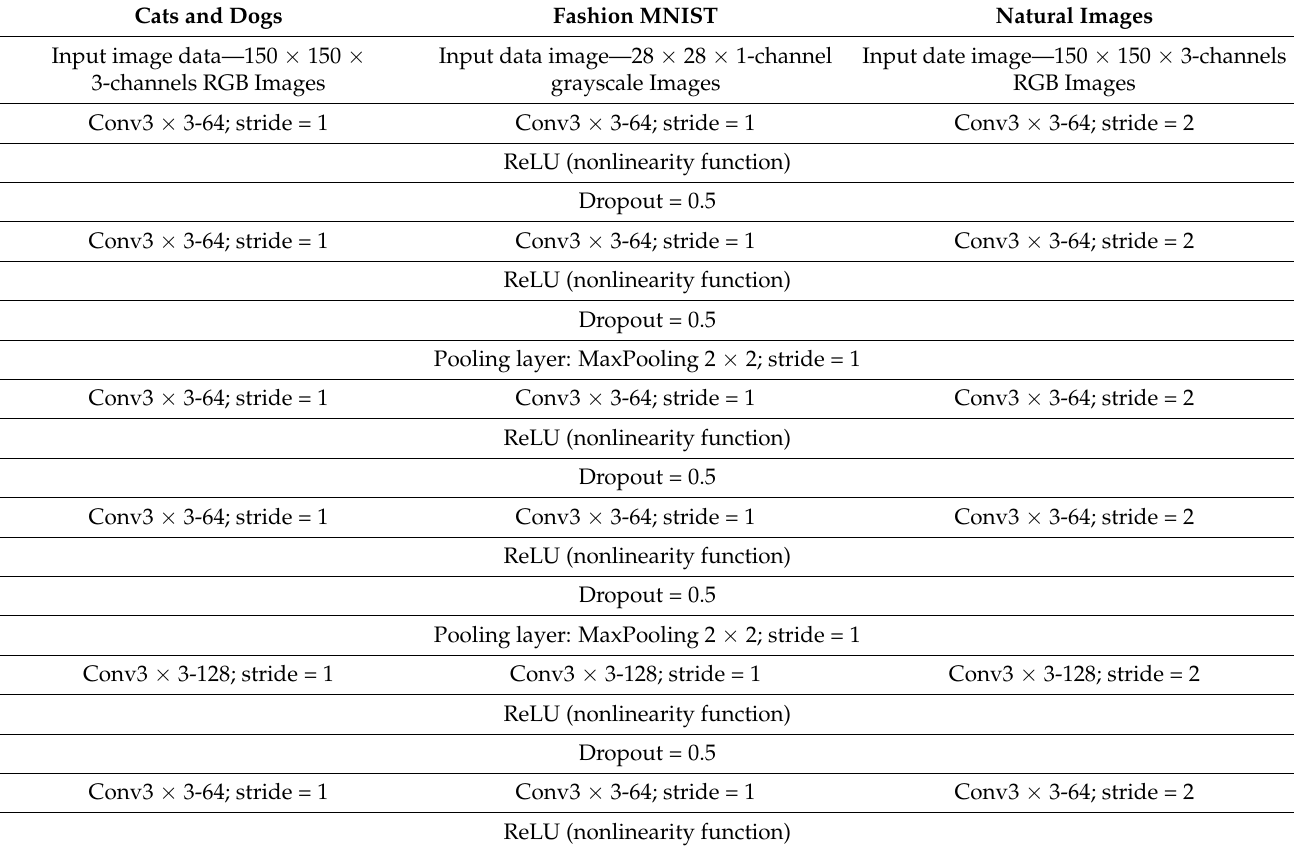
Table 7. Configuration summary of CNN with increasing depth and width denoted as d/w